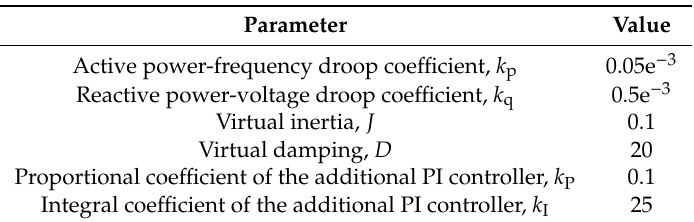
Table 2. Simulation parameters of single self-synchronizing voltage source.